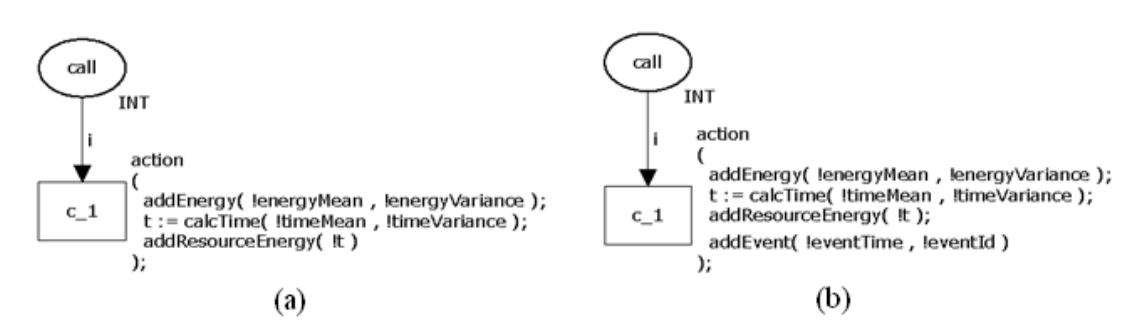
Figure 8. CPN models of the command call